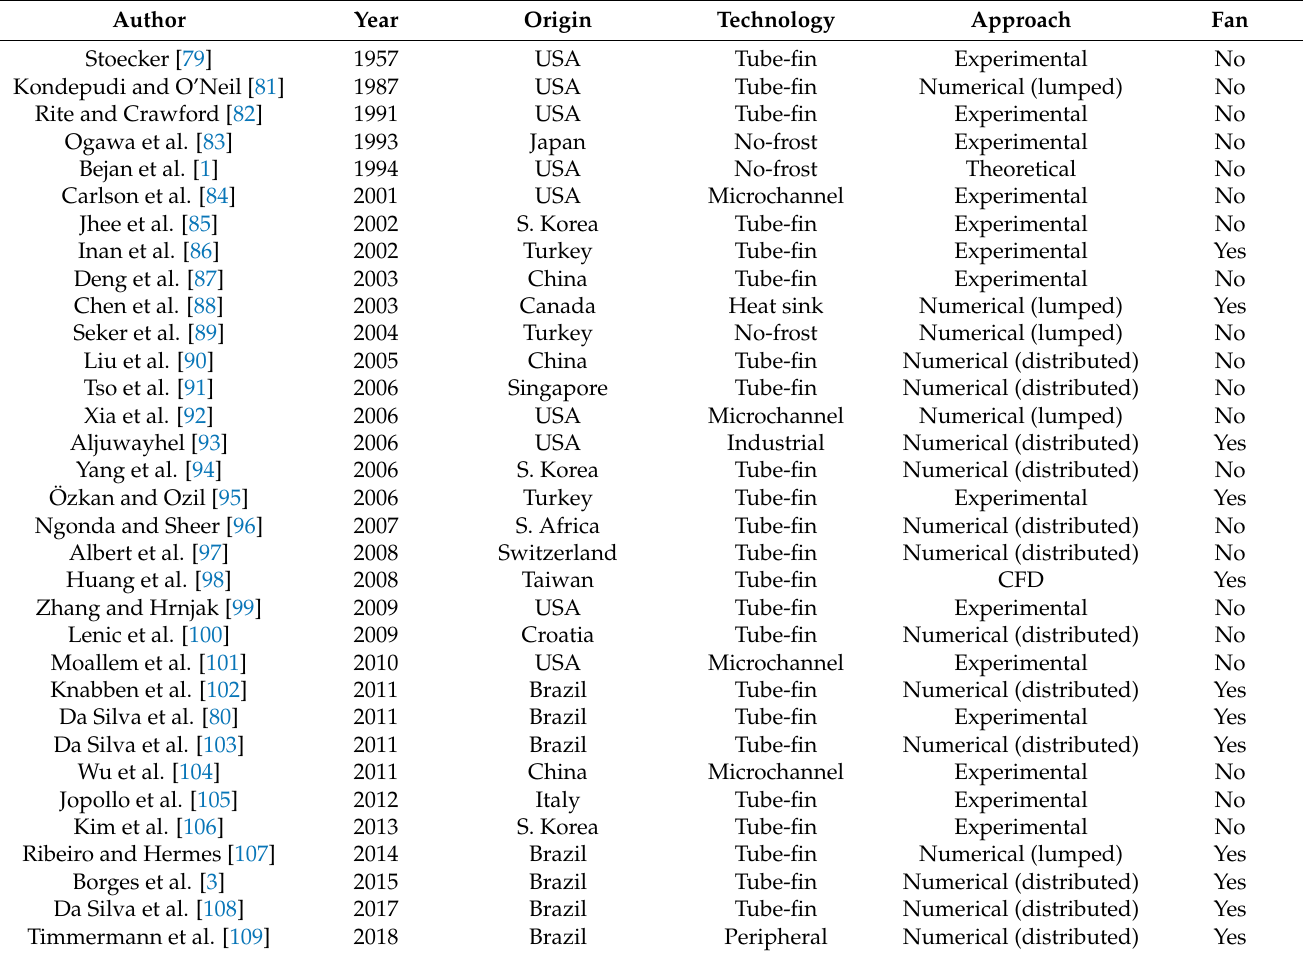
Table 2. Selected works on frost accretion over heat exchanger